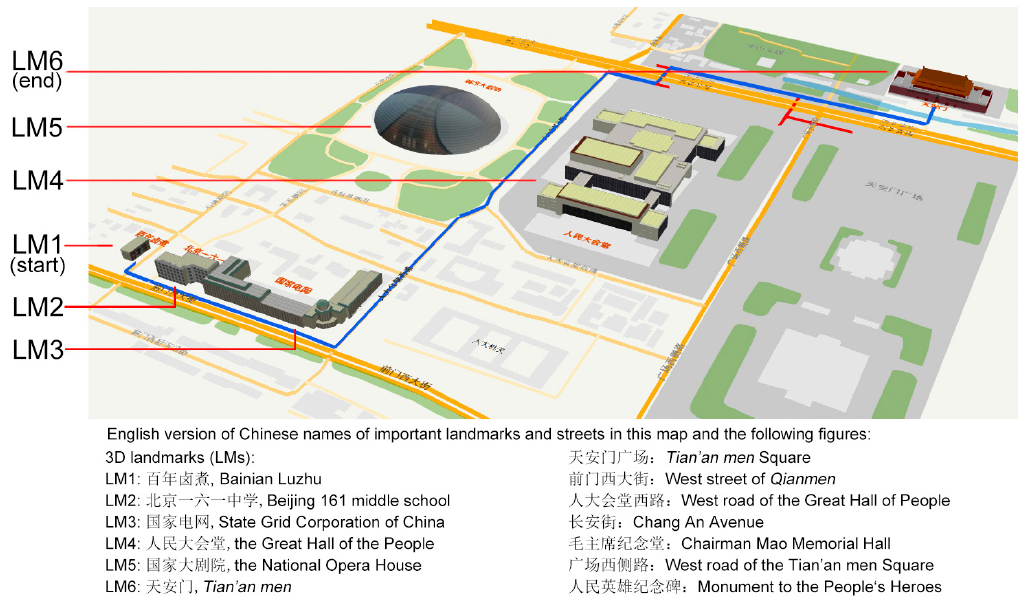
Figure 1. The designed 3D map of the experimental area (an oblique view). There are six 3D landmarks (LMs) for the pre-defined route including the start and the end points. The blue line indicates the pre-defined route.